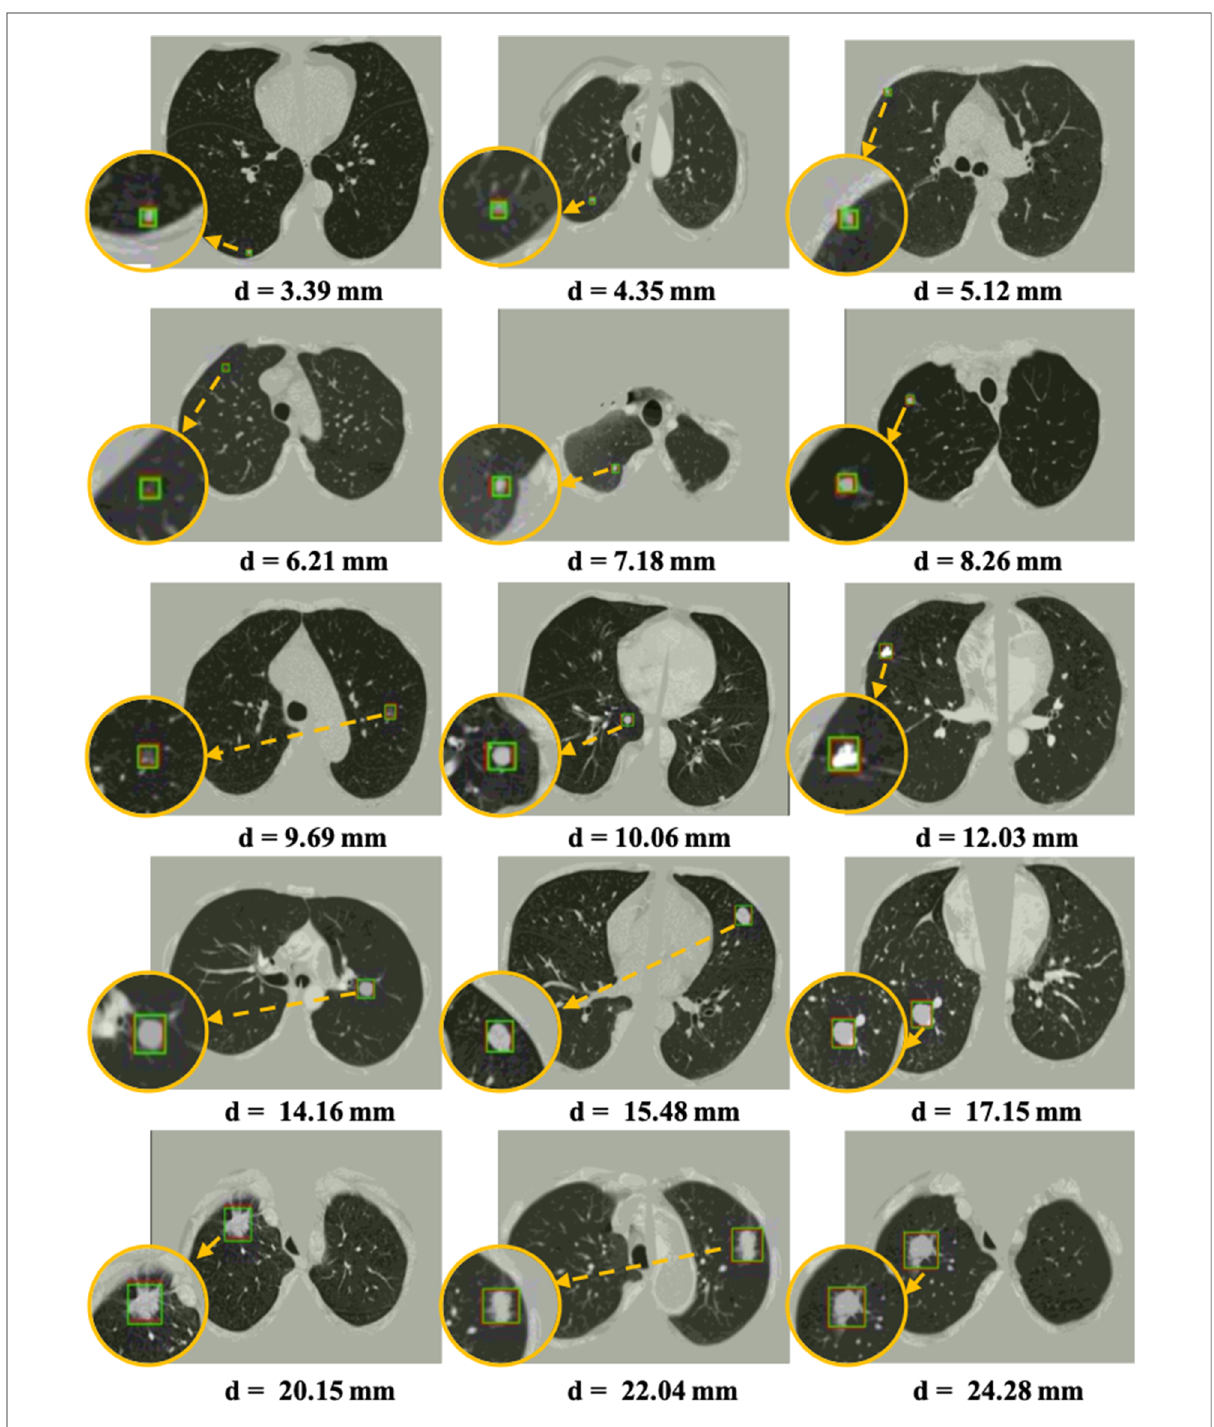
FIGURE 7 Visualization of some detected true nodules with different sizes from 3mm to 25mm in diameter d by our proposed 3DFPN-HS 2 framework. For better visualization, the detected nodule regions are zoomed in, as shown in the orange circles. The green box indicates the predicted region, and the red box represents the ground-truth. Some of the red boxes are not observed because they are perfectly overlapped with the green boxes. The results demonstrate that our 3DFPN-HS 2 framework is capable of detecting lung nodules of different sizes from CT scans